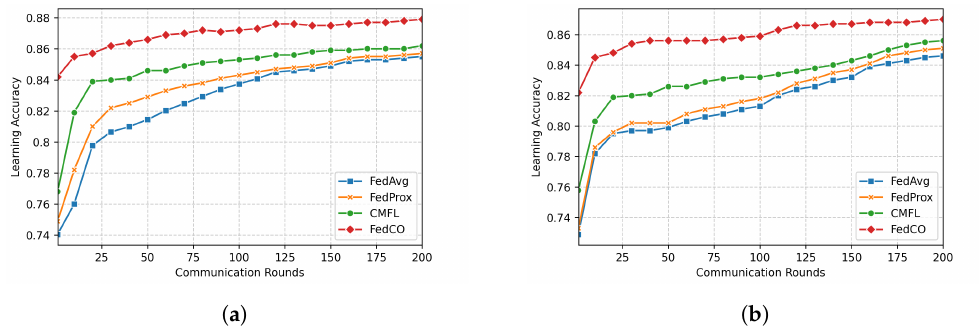
Figure 7. Learning accuracy versus communication rounds for the CIFAR-10 data. The top plot presents the results produced in the case of the IID data distribution scenario, while the bottom plot depicts the results generated in case of the Non-IID data distribution scenario. ( a ) IID; ( b )